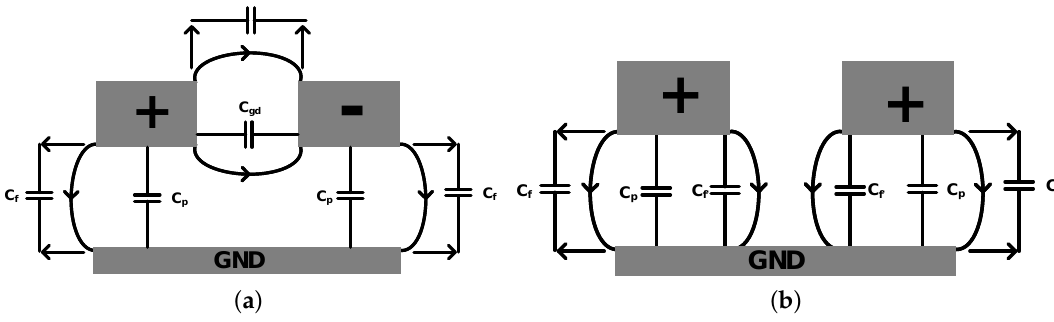
Figure 2. Capacitances of coupled lines under odd mode excitation ( a ) and even mode excitation ( b